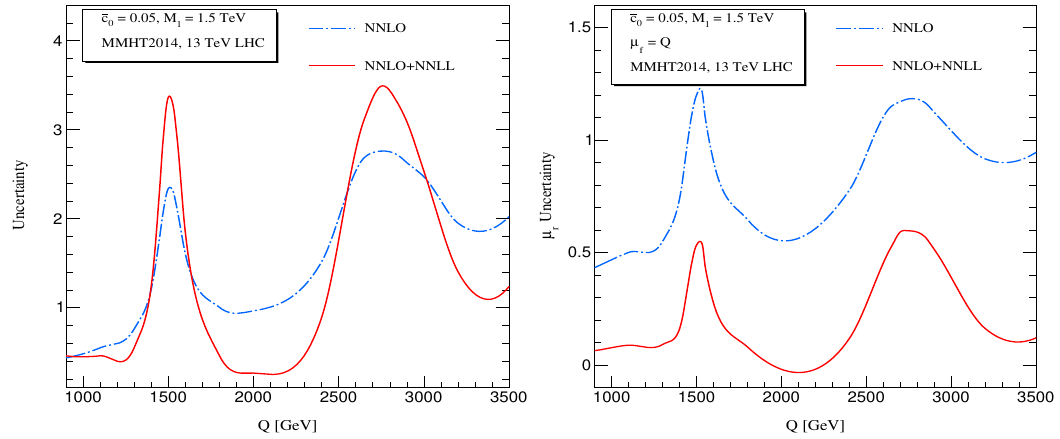
Figure 11 . Comparison of 7-point scale uncertainties at the signal for NNLO and NNLO+NNLL (left). The uncertainty only due to (cid:22) r scale variation around the central scale Q at NNLO and NNLO+NNLL (right) for (cid:12)xed (cid:22) f = Q . of (cid:12)gure 11). However, the factorization scale uncertainty for Q = 1500 GeV is found to increase (cid:6) 0 : 88% at NNLO to (cid:6) 2 : 58 at NNLO+NNLL level. The overall seven-point